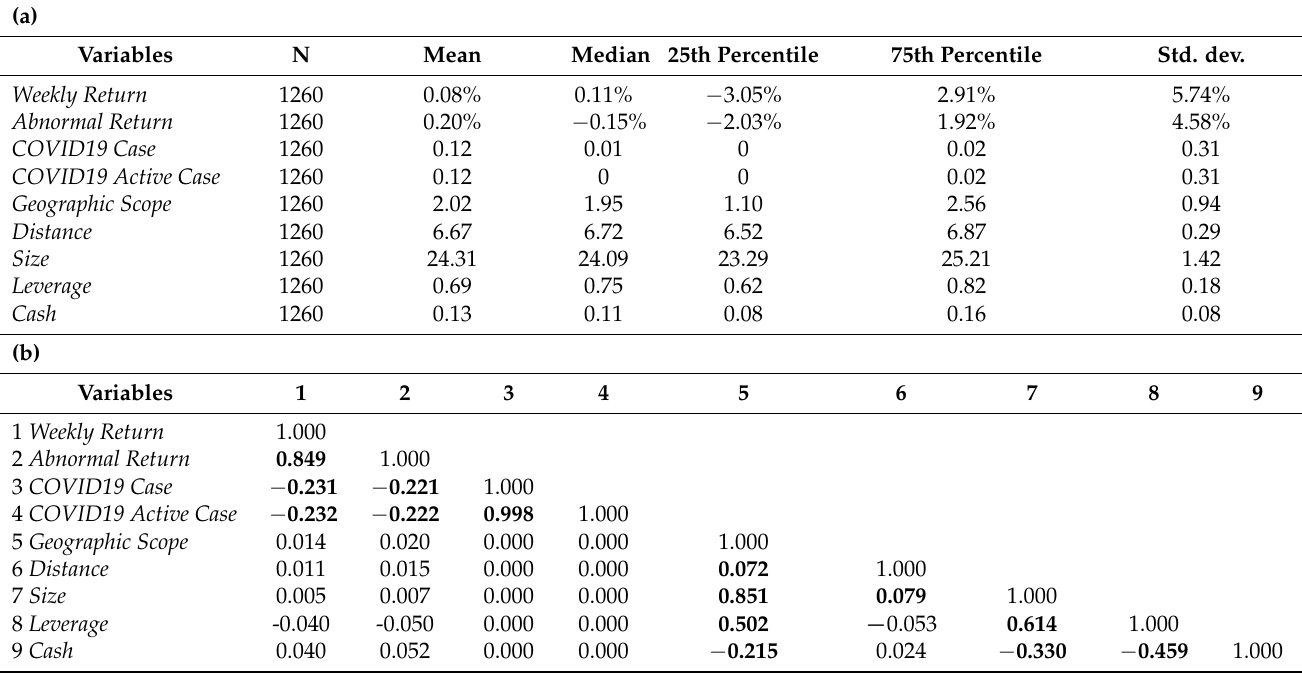
Table 1. Descriptive statistics and correlations. ( a ) Descriptive statistics; ( b )